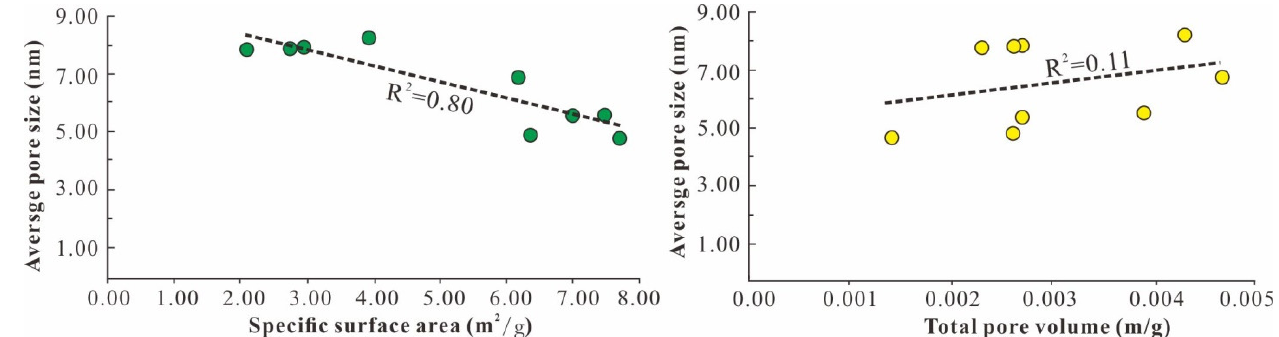
Figure 5. Relationship between specific surface area, total pore volume and pore size of shale.